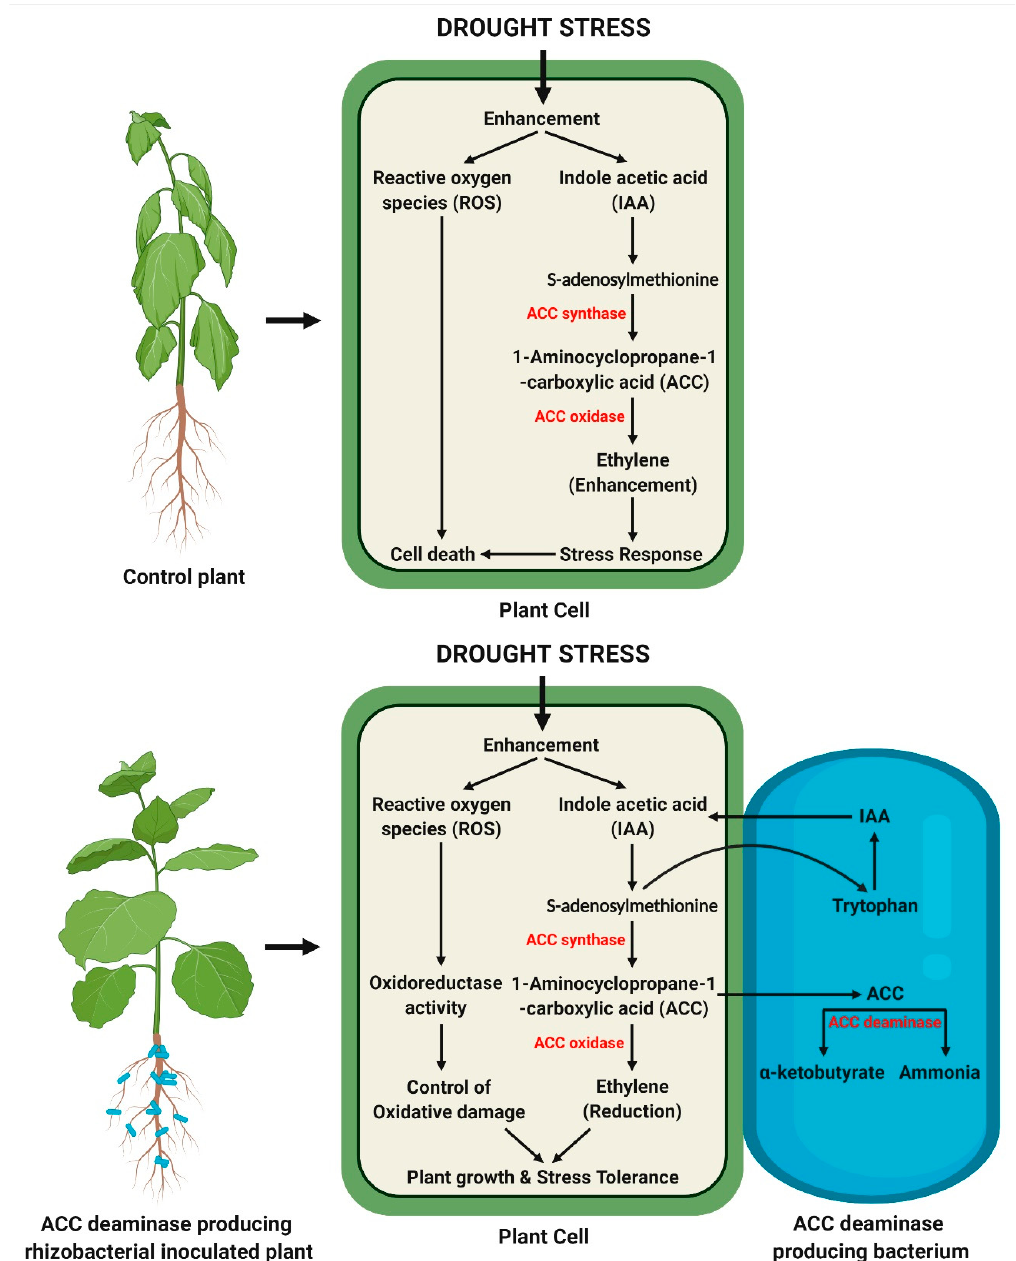
Figure 4. ACC deaminase producing PGPR-mediated mitigation of drought stress in plants.